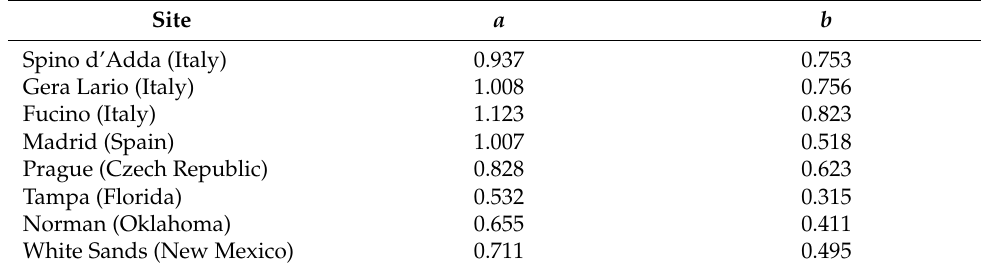
Table 2. Constants a and b of Equation (3) for the indicated sites.